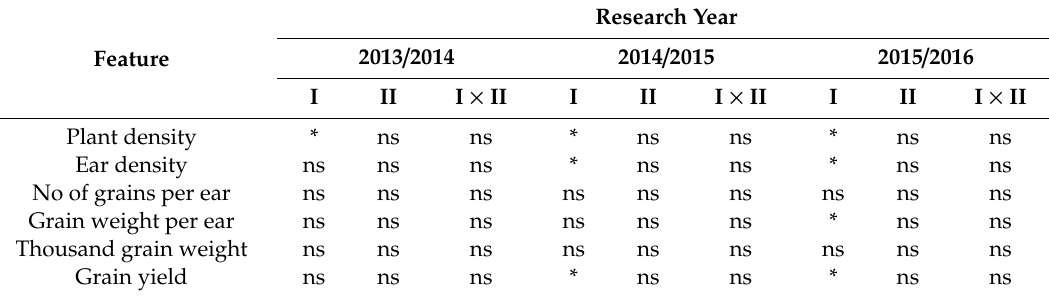
Table 1. Significance of the e ff ect of basic tillage, pre-sowing fertilisation and winter wheat sowing (I), post-harvest treatments (II), and the interaction of the factors (I × II) on yield components and winter wheat grain yield in the research years, F test (* – significant at p < 0.05; ns –